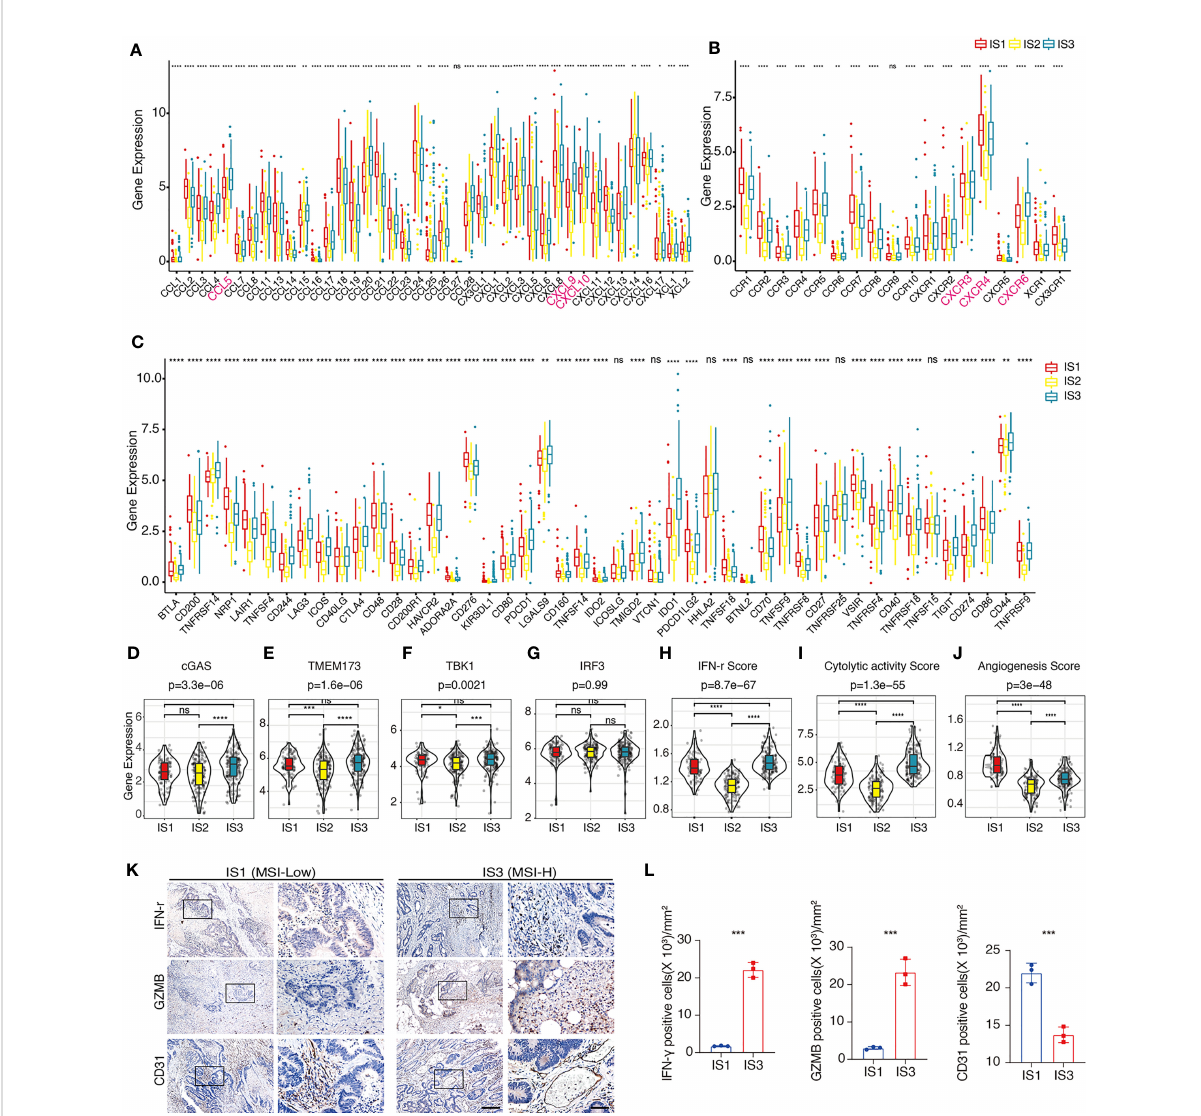
FIGURE 3 Distribution of immune-related molecular characteristics among ISs in TCGA-COAD and FUSCC cohorts (A, B) . Differential expression of chemokines (A) or chemokine receptors (B) among the COAD immune subtypes in TCGA-COAD cohort. CCL4 , CCL5 , CXCL9 , CXCL10 , CXCR3 , CXCR4 , and CXCR6 are highlighted in pink. The top and bottom of the box are the upper quartile (Q3) and the lower quartile (Q1) of the data, respectively. The solid line in the box represents the median. The whiskers represent the maximum and minimum values of this group of data. The Kruskal – Wallis test was used to assess for signi fi cant differences. ns not signi fi cant, * P < 0.01, ** P < 0.001, *** P < 0.0001, and **** P < 0.00001. (C) . Differential expression of immune checkpoint-related genes among the COAD immune subtypes in TCGA-COAD cohort. The top and bottom of the box are the upper quartile (Q3) and the lower quartile (Q1) of the data, respectively. The solid line in the box represents the median. The whiskers represent the maximum and minimum values of this group of data. The Kruskal – Wallis test was used to assess for signi fi cant differences. ns not signi fi cant, * P < 0.01, ** P < 0.001, *** P < 0.0001, and **** P < 0.00001. (D – G) . Differential expression of cGAS (D) , TMEM173 (E) , TBK1 (F) , and IRF3 (G) among the COAD immune subtypes in TCGA-COAD cohort. We used the Kruskal – Wallis test and Wilcox test to compare the signi fi cance among the three groups and pairwise comparison between groups, respectively. The solid black line in the box represents the median, and the black box in the violin plot represents the quartile range. The black vertical line running through the violin chart represents the interval from the minimum value to the maximum value, respectively. ns not signi fi cant, * P < 0.01, ** P < 0.001, *** P < 0.0001, and **** P < 0.00001. (H – J) . The estimated IFN- g level (H) , CYT level (I) , and angiogenesis level (J) among the COAD immune subtypes in TCGA-COAD cohort. We used Kruskal – Wallis test and Wilcoxon test to compare the signi fi cance among the three groups and pairwise comparison between groups, respectively. The solid black line in the box represents the median, and the inner black box in the violin plot represents the quartile range. The black vertical line running through the violin chart represents the interval from the minimum value to the maximum value, respectively. ns not signi fi cant, * P < 0.01, ** P < 0.001, *** P < 0.0001, and **** P < 0.00001. (K) . Representative IHC result of IFN- g , GZMB, and CD31 in dMMR and pMMR subtypes in the FUSCC cohort. The box area is magni fi ed in the right panel. Scale bars: 100 µm (left panel) and 20 µm (right panel). (L) . Scatter plots show the difference of IFN- g , GZMB, and CD31 in dMMR and pMMR subtypes in the FUSCC cohort. Unpaired t-test. Data are shown as mean ± SD. ***P <